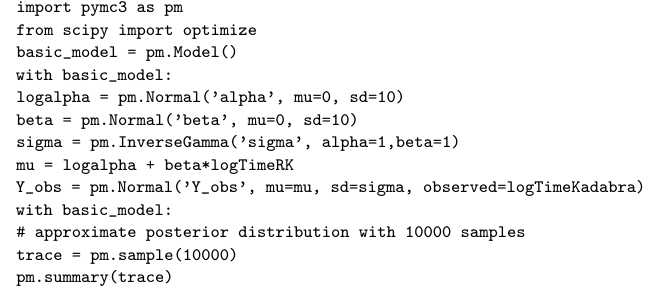
Figure 8. Example listing for inference of parameters α A / B , β A / B and σ A / B